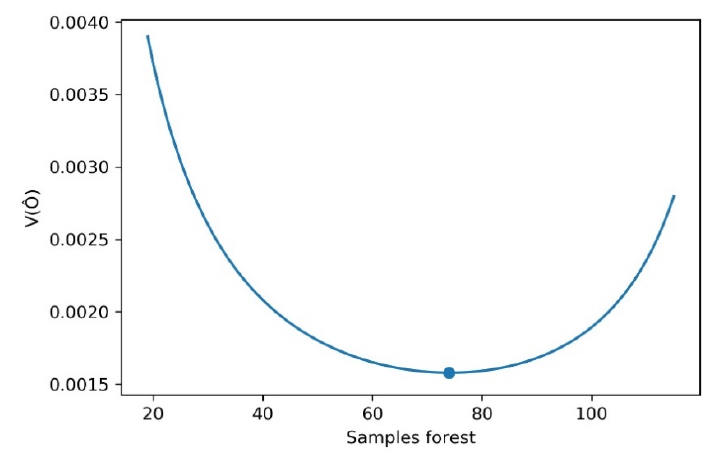
Figure 3. Changes in the variance of the overall accuracy (V( Ô )) depending on the number of samples assigned to the forest class for the AOI ESP-1. The optimal number of forest samples to minimize the variance was 73.